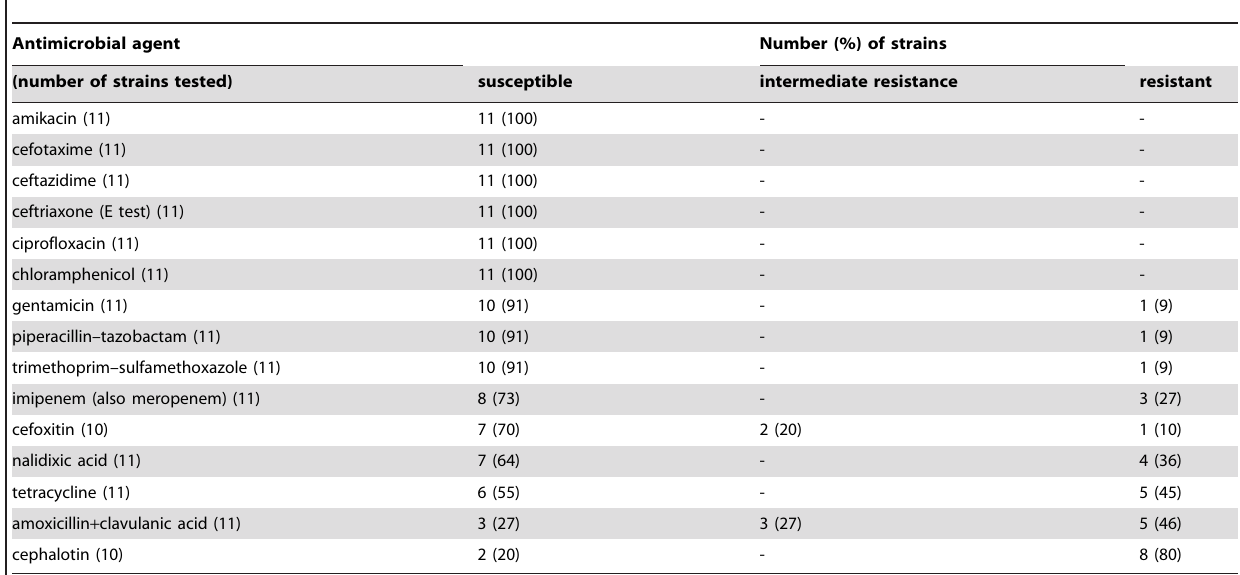
Table 2. Susceptibility of Aeromonas isolates to antimicrobial agents.